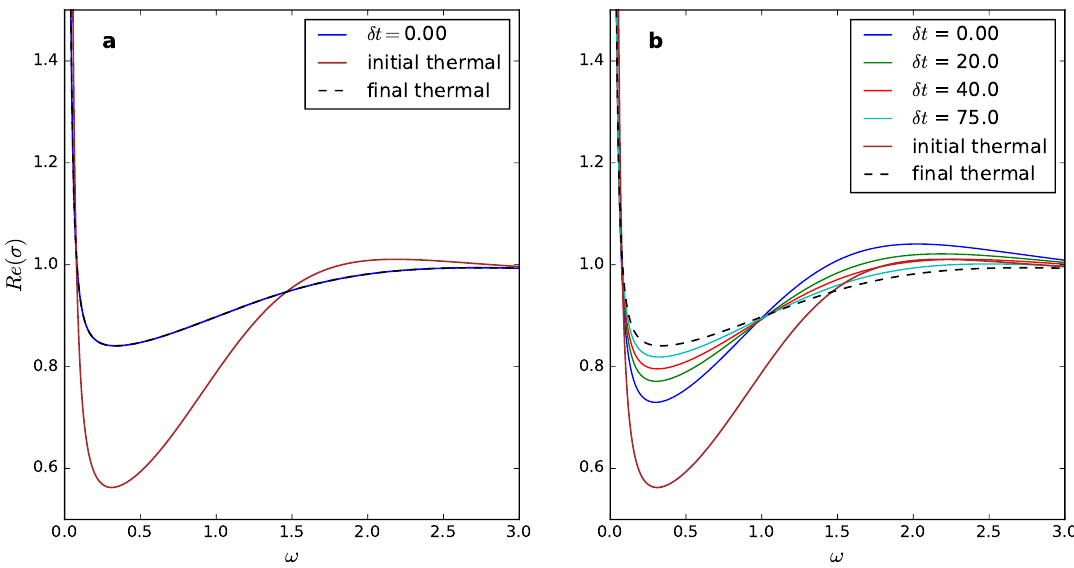
Figure 10 . The optical conductivity at di(cid:11)erent times and in the initial and the (cid:12)nal thermal equilibrium states. Left: the pump frequency is ! P = 0 : 5, and the optical conductivity right after the pump pulse has ended coincides with the (cid:12)nal equilibrium one. Right: the pump frequency is ! P = 0, and the optical conductivity is seen to interpolate in time between the initial and (cid:12)nal equilibrium